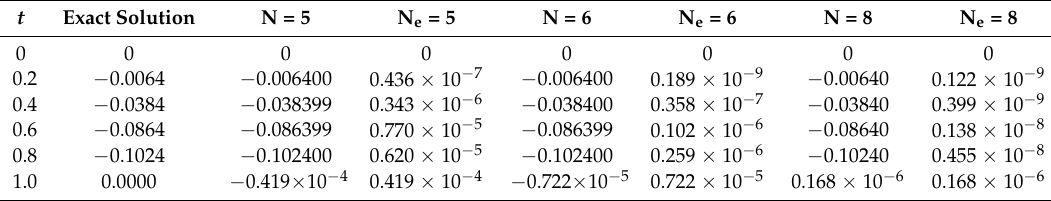
Table 2. Numerical result for approximate solution of y 2 ( t ) in Example 2.